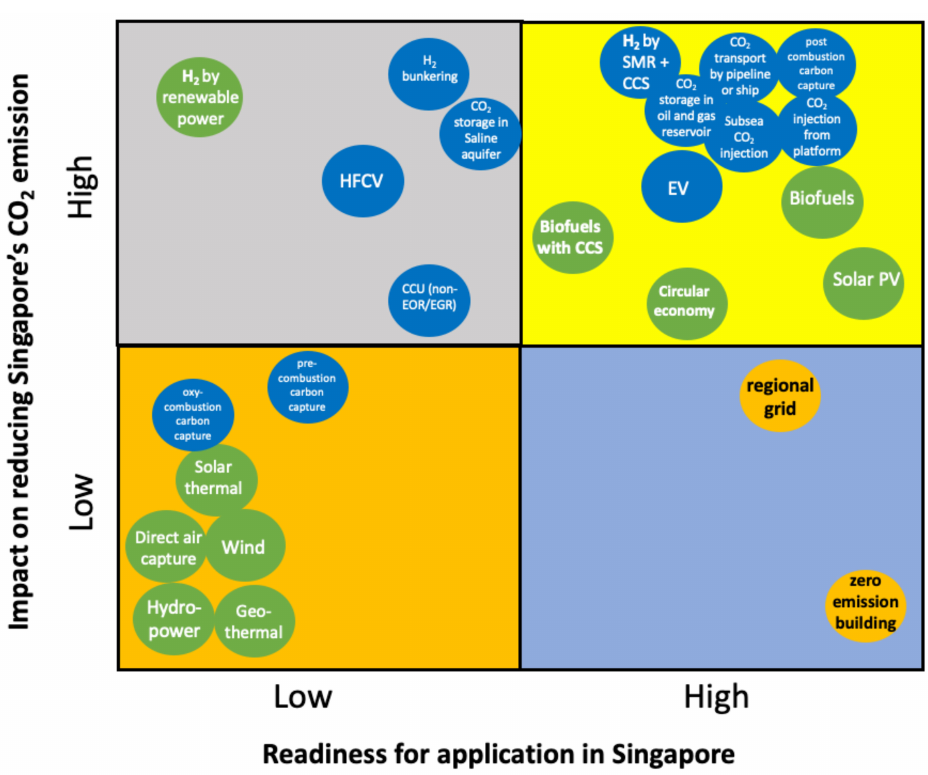
Figure 4. Technology mapping for decarbonizing Singapore. Table 1. Ranking of the impact and readiness of various technologies on the decarbonization of